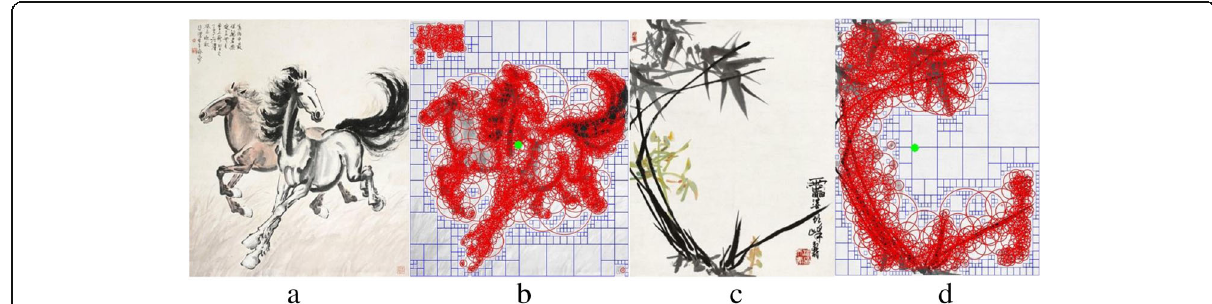
Fig. 1 Comparison of two paintings with local symmetry marked by red circles, white space marked by blue lines and mass center marked by filled green circles. a Two Horses; b Rating score of visual order on Two Horses: 5.94, local symmetry (gradient): 86, white space: 44.1%, mass center: − 0.0034, 0.0129; c Orchid and Bamboo; d Rating score of visual order on Orchid and Bamboo: 5.37, local symmetry (gradient): 202, white space: 33.6%, mass center: − 0.1101, −